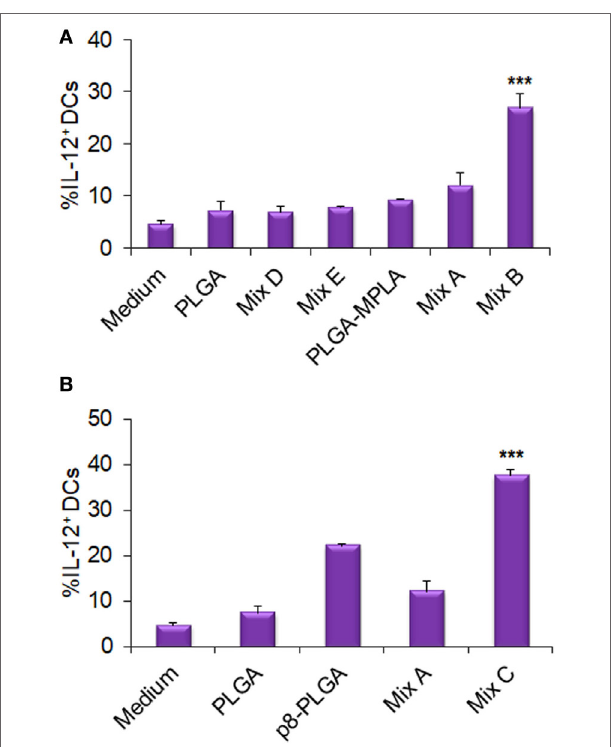
FigUre 5 | Functional differentiation of dendritic cells (DCs) stimulated with the differentially functionalized peptide-based poly(lactic- co -glycolic) acid (PLGA) nanoformulations in terms of IL-12 production. DCs were cultured for 24 h upon stimulation with the mix of PLGA-chCPAp, PLGA-chH1p, and PLGA-chKMP-11p nanoformulations (mix A), the mix of PLGA-chCPAp- MPLA, PLGA-chH1p-MPLA, and PLGA-chKMP-11p-MPLA nanoformulations (mix B), the mix of p8-PLGA-chCPAp, p8-PLGA-chH1p, and p8-PLGA- chKMP-11p nanoformulations (mix C), the mix of soluble chimeric peptides (mix D), and the mix of soluble chimeric peptides plus MPLA (mix E). DCs cultured in medium alone were used as negative control. DCs were also stimulated with empty PLGA nanoparticles (NPs), PLGA NPs with MPLA encapsulated, and PLGA NPs surface modified with p8 as control groups. The diagrams indicate the effect of MPLA incorporation (a) or the effect of surface modification with p8 (B) in the percentage of DCs producing IL-12. Results are expressed as the mean ± SD of three independent experiments. Significant differences between DCs stimulated with the mix B or the mix C and DCs stimulated with the mix A are indicated by *** p < 0.001.